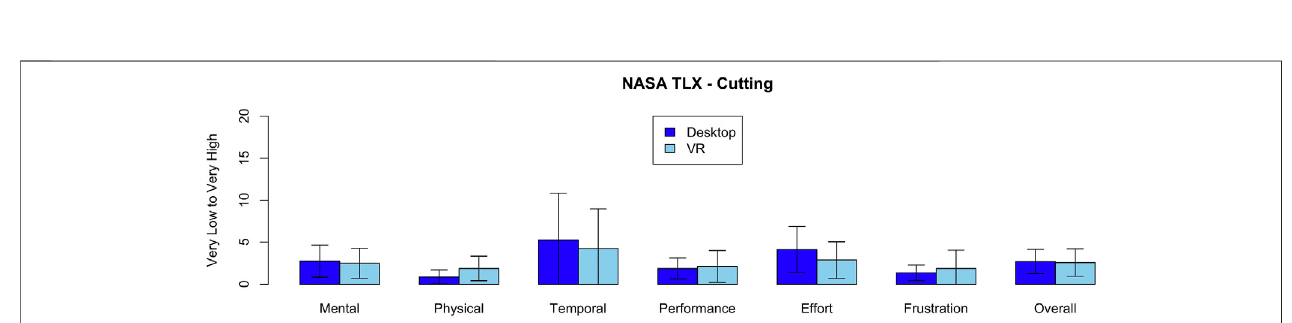
FIGURE 8 | Task 1: TLX values for the arranging task comparing the Desktop and the VR condition.